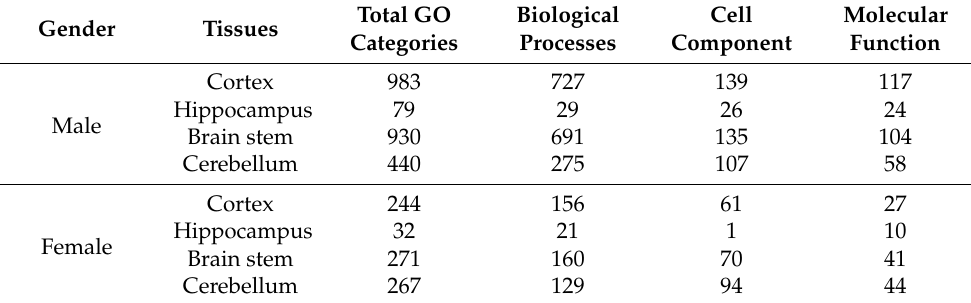
Table 1. GO categories of